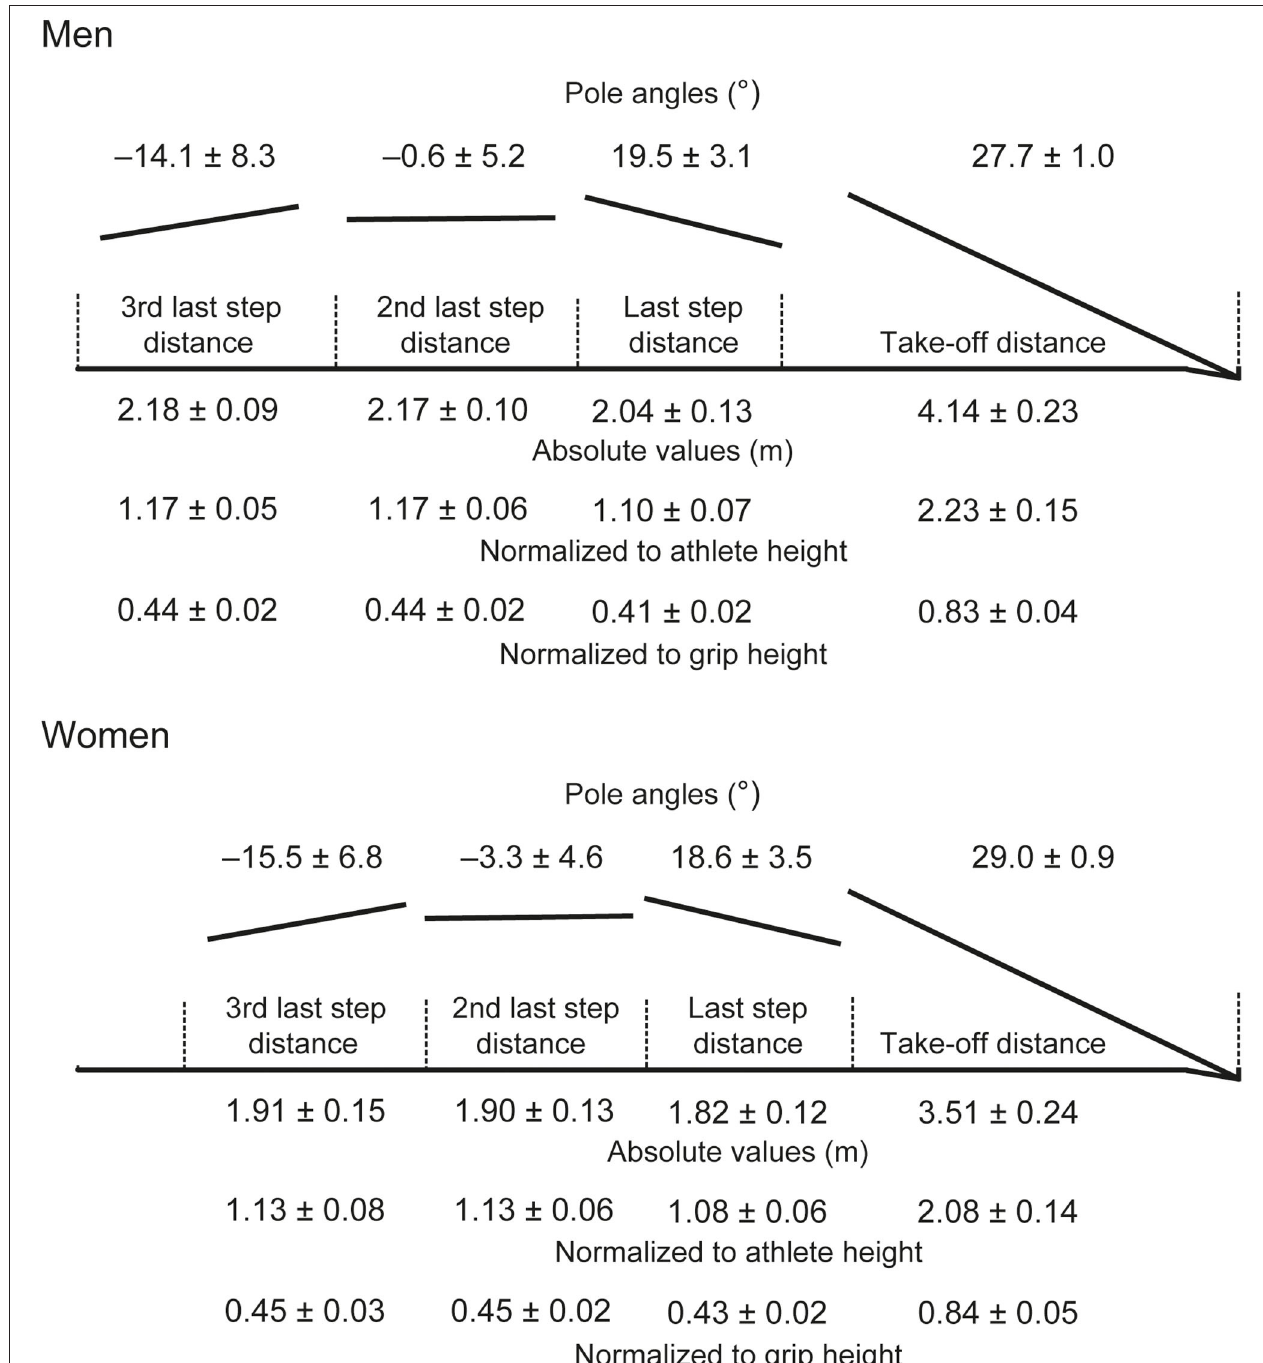
FIGURE 1 | Visual representation of the last three steps and take-off distance, with the angle of the pole during each step included (negative values indicate that the end of the pole held by the vaulter was lower than the pole tip). The plant box is shown as the athletes would approach it running from left to right. The diagram is approximately to scale, with separate diagrams for men and women. The mean values ( athlete stature and position of the upper hand on the pole. pole mass on velocity (Angulo-Kinzler et al., 1994; Frère et al., 2010) might have influenced their decision to take fewer run-up